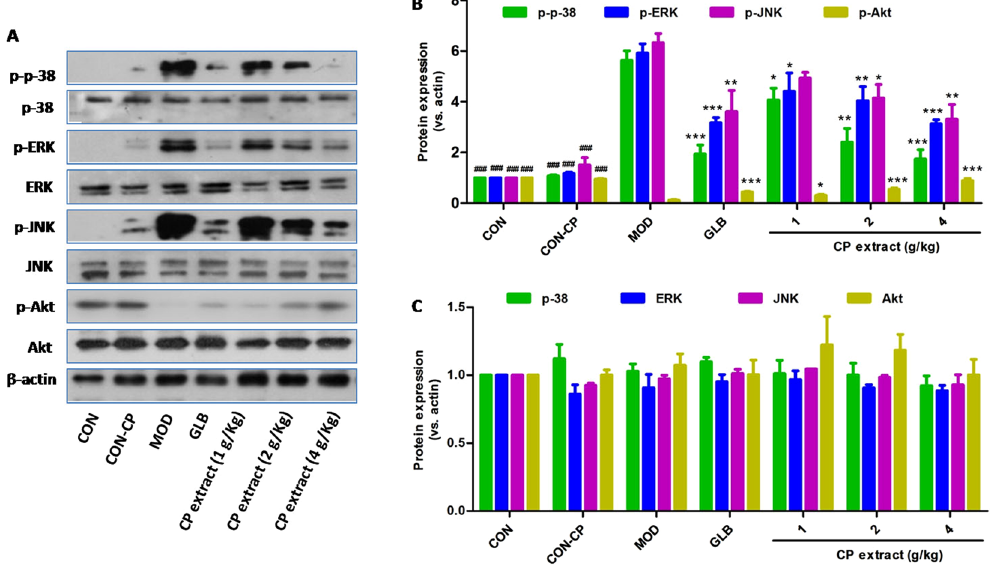
Figure 5. CP extract suppresses MAPK signals and activates Akt signal in pancrease tissues of diabetic mice. The type 2 diabetic mice were induced by feeding with high-fat diet for 4 weeks and then injecting intraperitoneally with 25 mg/kg STZ for 3 days consecutively. The diabetic mice with consecutive 7-day hyperglycemia (11 mmol/L or greater) were selected for the experiment and then CP extract or glibenclamide were administered to mice for consecutive 5 weeks. At the end of experiment, mice were sacrificed. The samples of pancrease tissues were collected. Protein expressions of p-p38, p38, p-ERK, ERK, p-JNK, JNK, p-Akt and Akt were determined in pancreas tissues using Western blot. ( A ) Representative image of Western blot; ( B ) Protein expressions of p-p38, p-ERK, p-JNK and p-Akt in pancreas tissues. ( C ) Protein expressions of p38, ERK, JNK, and Akt in pancreas tissues. All data are presented as means ± SEM (n = 8). # p < 0.05, ## p < 0.01 and ### p < 0.001, diabetic model group compared with non-diabetic groups; * p < 0.05, ** p < 0.01 and *** p <